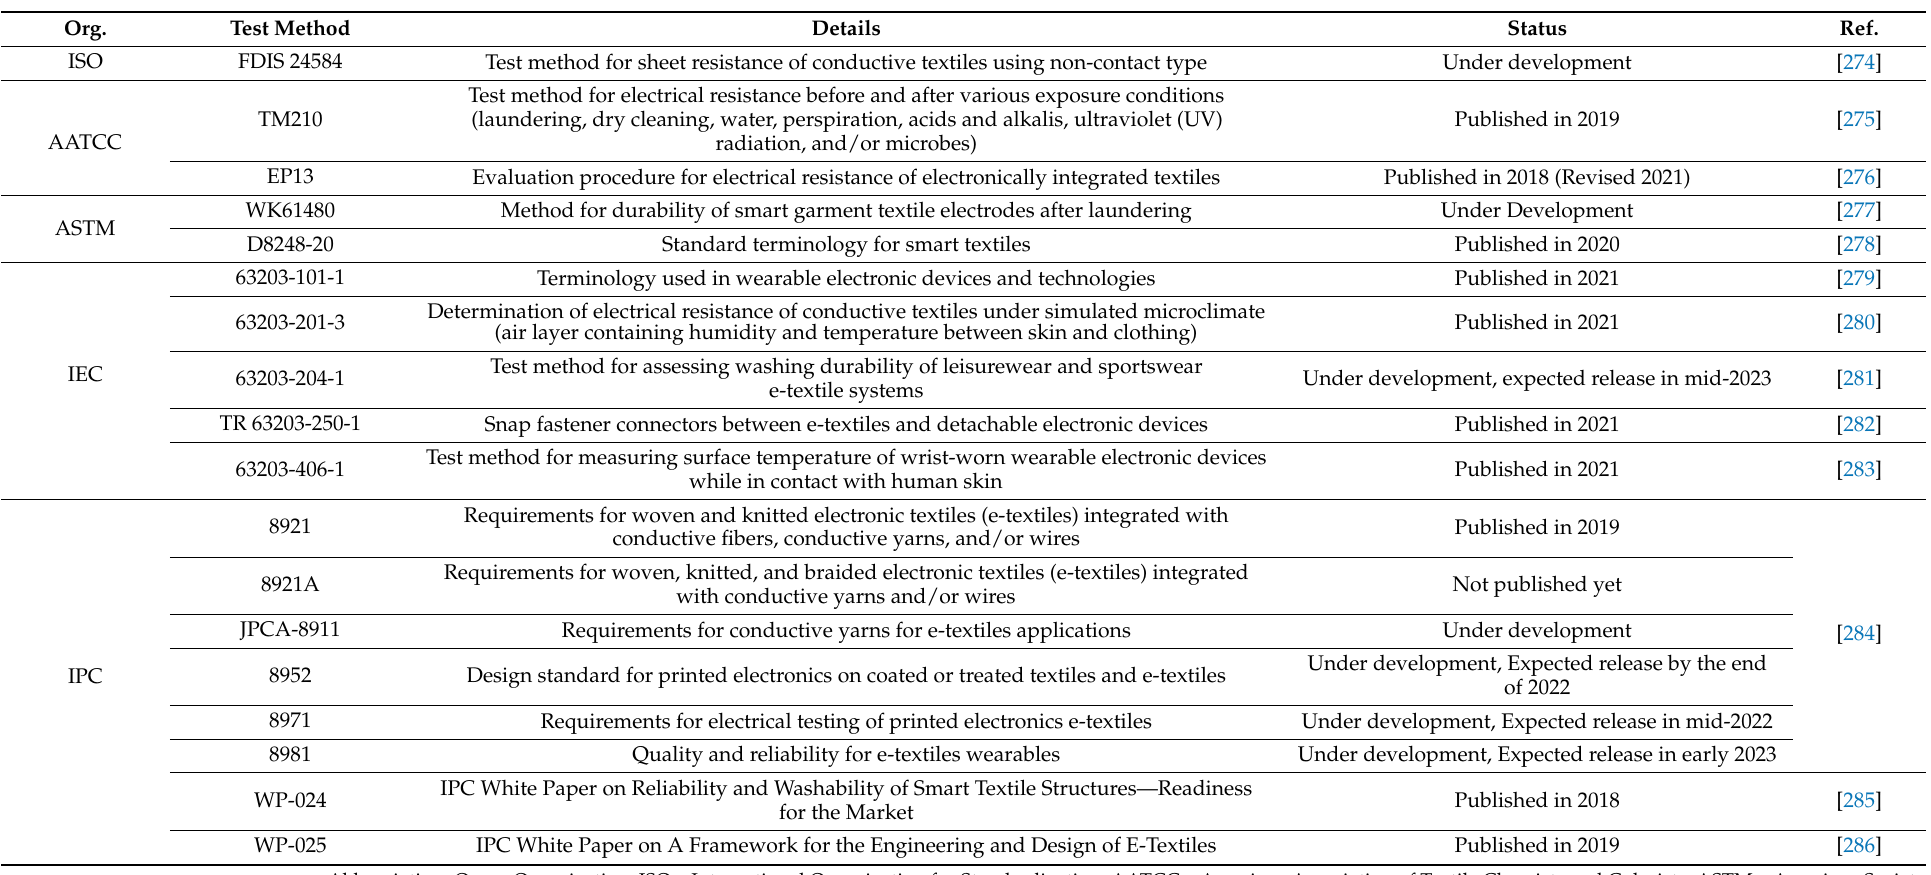
Table 6. Summary of different existing and forthcoming e-textile